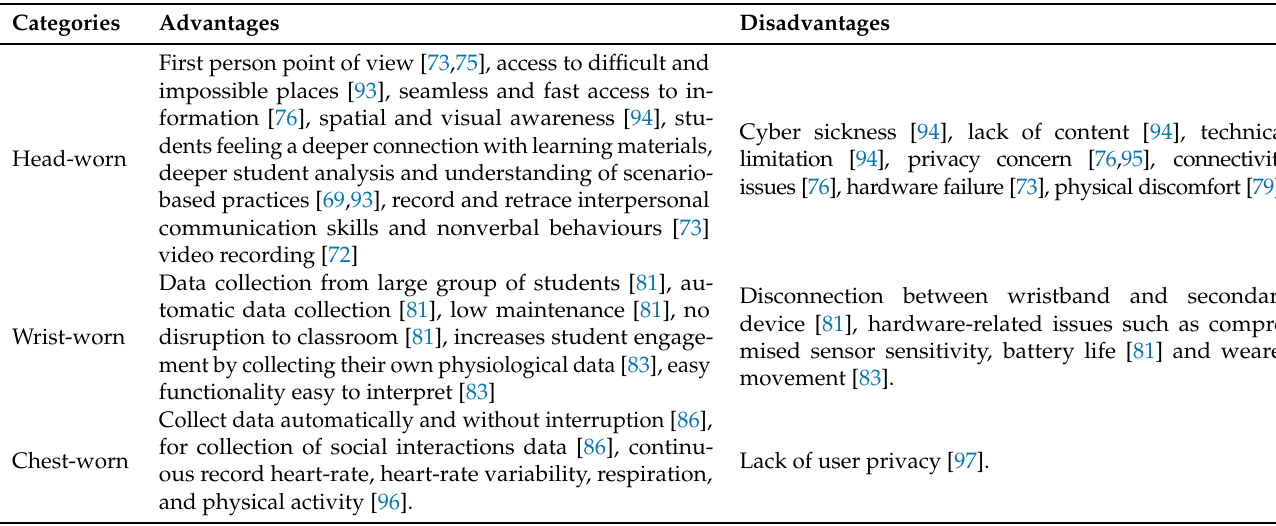
Table 4. Advantages and disadvantages of wearable devices in higher